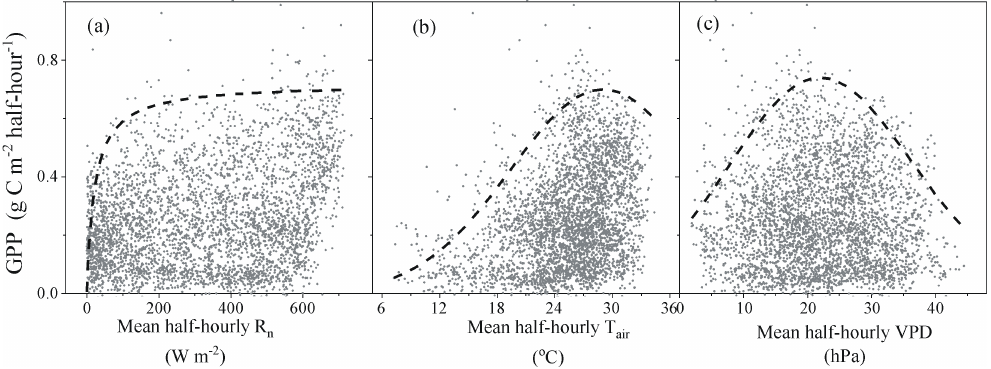
Fig 5. The response curves of total half-hourly GPP (gross primary production) to mean half-hourly R n (net solar radiation) (a), T air (air temperature) (b), and VPD (vapor pressure deficit) (c) at the 95% confidence